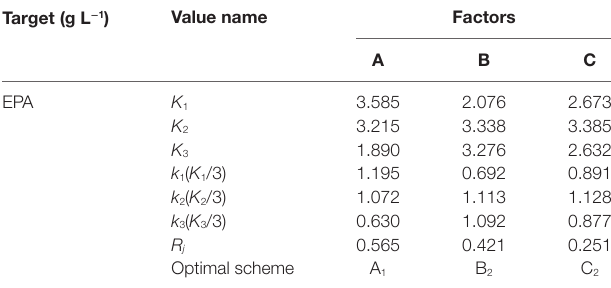
TaBle 5 | Range analysis data.